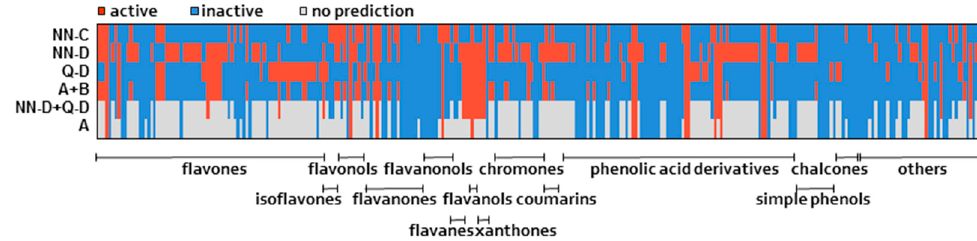
Figure 5. Representation of classification of 300 compounds with three separate classification models (NN-C, NN-D, Q-D) and three consensus models (A + B, NN-D + Q-D, A) on graphical map.